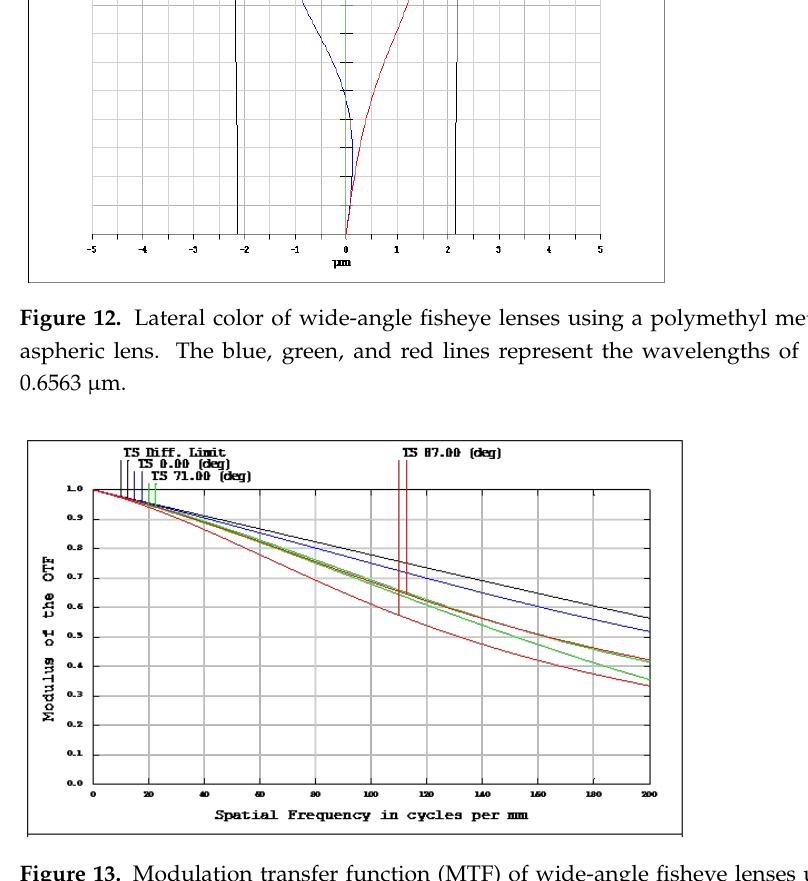
Figure 13. Modulation transfer function (MTF) of wide-angle fisheye lenses using a polymethyl methacrylate (PMMA) aspherical lens. The blue, green, and red lines represent the tangential and sagittal (T = tangential; S = sagittal) directions for the 0°, 71°, and 87°cases, respectively.